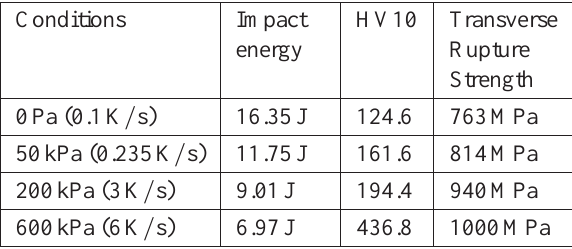
Table 1. Mechanical properties of investigated low alloyed sintered